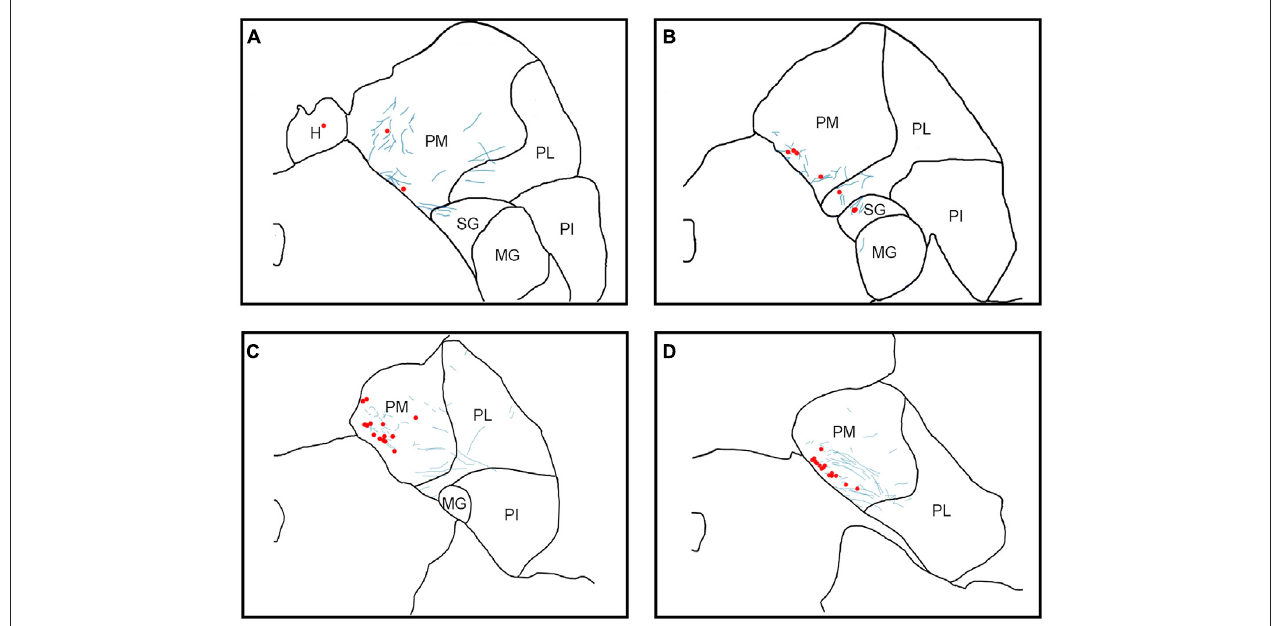
FIGURE 3 | Pattern of overlapping label in Case Y1. Each panel (A–D) presents a plot of labeled cell bodies or fibers from different rostro-caudal levels through the pulvinar. Anterograde label (putative axons) after injection of FE in the SC are shown in cyan. Retrograde label (cell bodies) after injection of CTB in the amygdala are shown in red. Abbreviations for thalamic nuclei are as in Figure 1